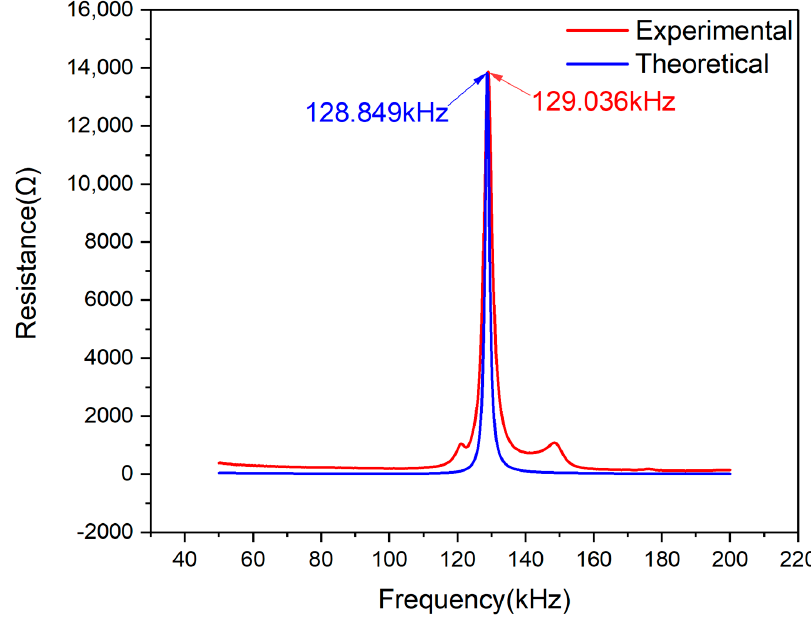
Figure 10. Experimental and theoretical resistance plots comparison of PZT#2.